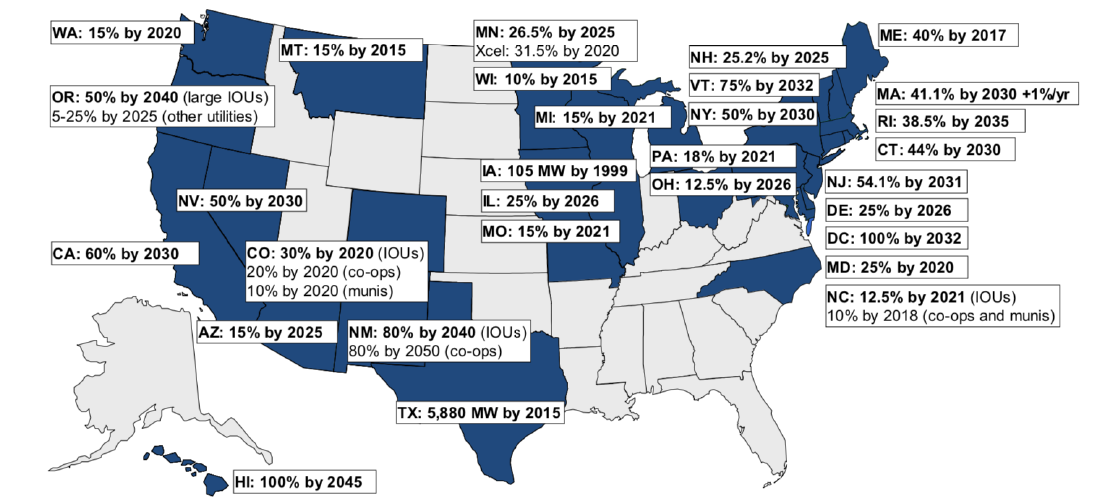
Figure 9. U.S. Renewable Portfolio Standards 2018 status